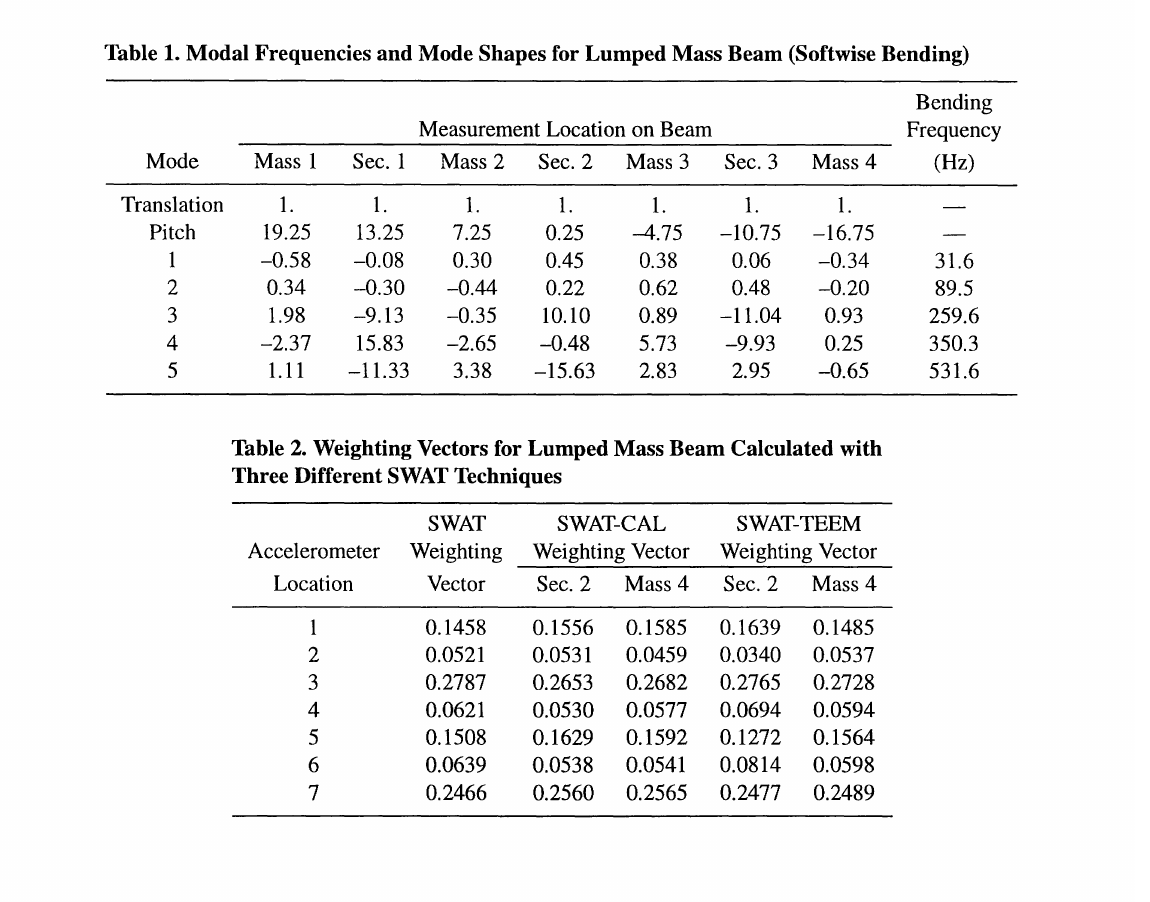
Table 1. Modal Frequencies and Mode Shapes for Lumped Mass Beam (Softwise Bending) Bending Measurement Location on Beam Frequency